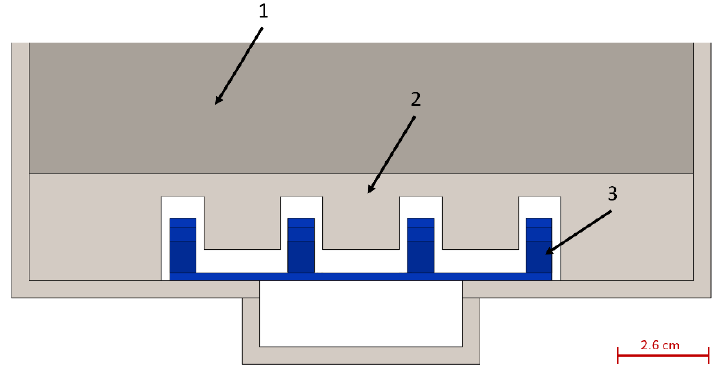
Figure 5. ( 1 ) Ramp within the hopper; ( 2 ) Slotted hopper door; ( 3 ) Matching cups.